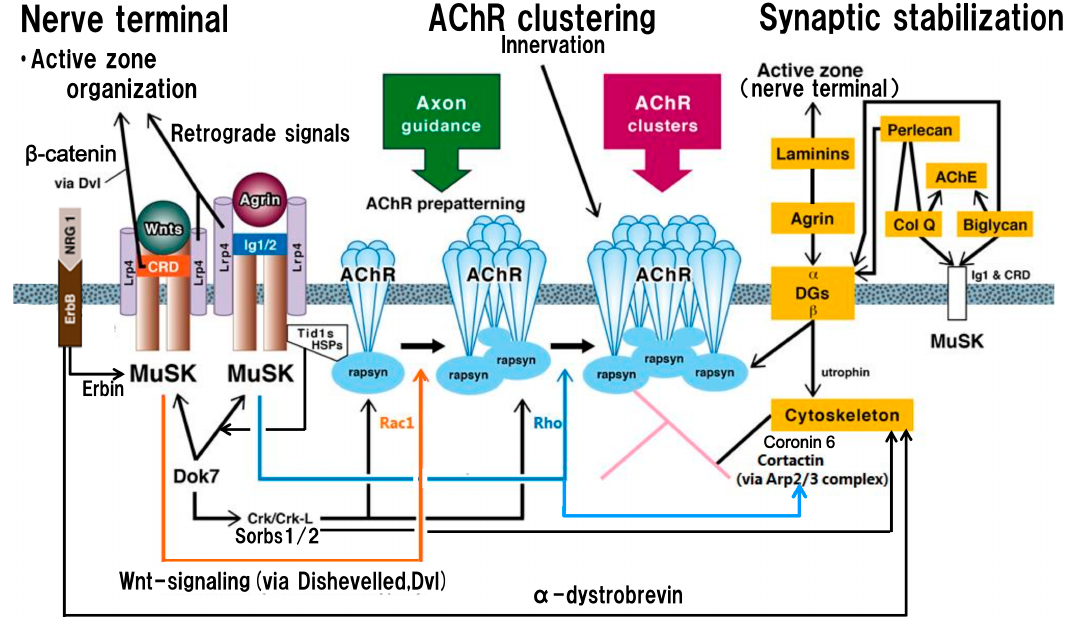
Figure 1. Schematic presentation of the postsynaptic structure and function on the basis of acetylcholine receptor clustering centered on agrin- and Wnt-signalings, trans-synaptic communication and synaptic stabilization. In the postsynaptic membrane, nicotinic acetylcholine receptors (nAChRs) are aggregated in the non-innervated stage via Wnts-MuSK cysteine-rich domain (CRD)-dishevelled protein signaling pathway to form nAChR microclusters (AChR prepatterning: located in the central part of the muscle membrane where incoming axons are guided) (orange line with arrow; via activation by Rac1), and in the innervated stage via agrin-MuSK immunoglobulin-like domains 1 and 2 (Ig1/2) signaling pathway to form full-sized nAChR clusters (blue line with arrow; via activation by Rho). The nAChR clusters in non-innervated and innervated stages are anchored by rapsyn (immobilized by heat-shock proteins, HSPs, including tumorous imaginal disc 1 short form, Tid1s, which belongs to HSP40 family) at the postsynaptic membrane. The kinase activity and subsequent downstream signalings by the intracellular tyrosine kinase domain of MuSK, located after the transmembrane segment, are crucial for the formation and maintenance of the neuromuscular junction. The low-density lipoprotein receptor-related protein 4 (Lrp4) plays an essential role in agrin- and Wnts-signaling pathways as the receptor for both signals. In the molecular structure of Lrp4, the first propeller domain interacts with agrin; in the third β -propeller domain, its edge part mediates the MuSK signaling and its central cavity mediates the Wnt signaling. As the trans-synaptic communication, the signaling mediated by Wnts-MuSK CRD contributes to the retrograde signal from muscle to nerve (Wnt canonical pathway via dishevelled protein (Dvl) and β -catenin), leading to presynaptic differentiation to localize active zone proteins for efficient synaptic transmission (left